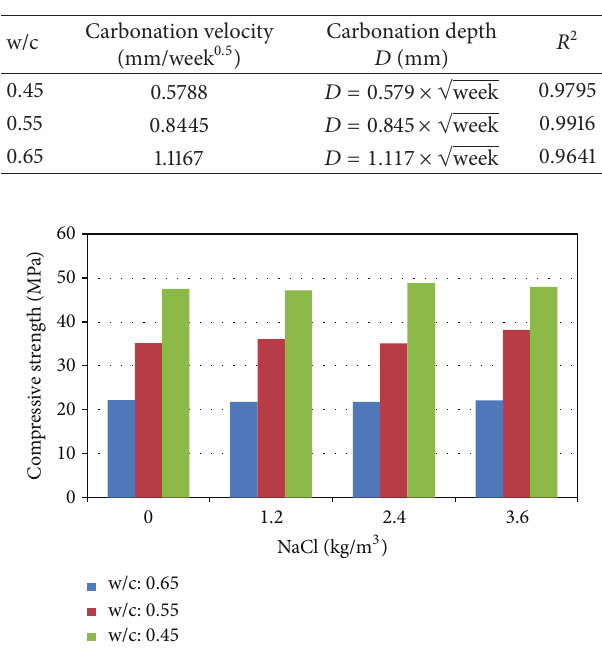
5 ∼ 20 GHz range are, respectively, averaged as one value to obtain parameter. Each averaged value of conductivity and dielectric constant is plotted in Figure 8 with w/c ratios considering chloride contents.